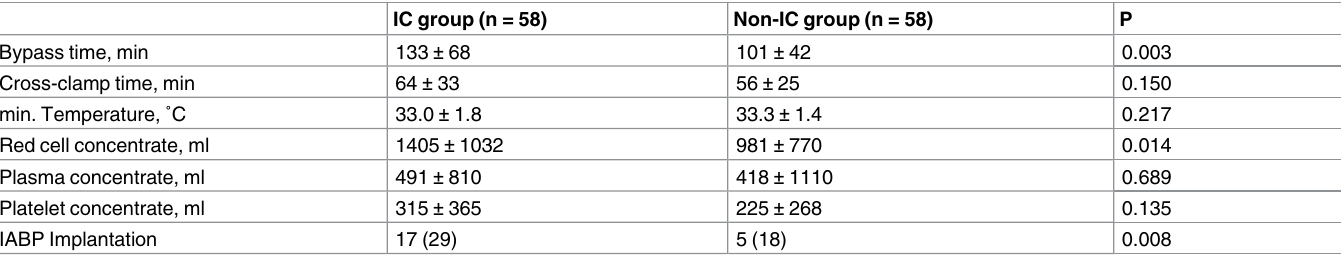
Table 2. Operation Data.